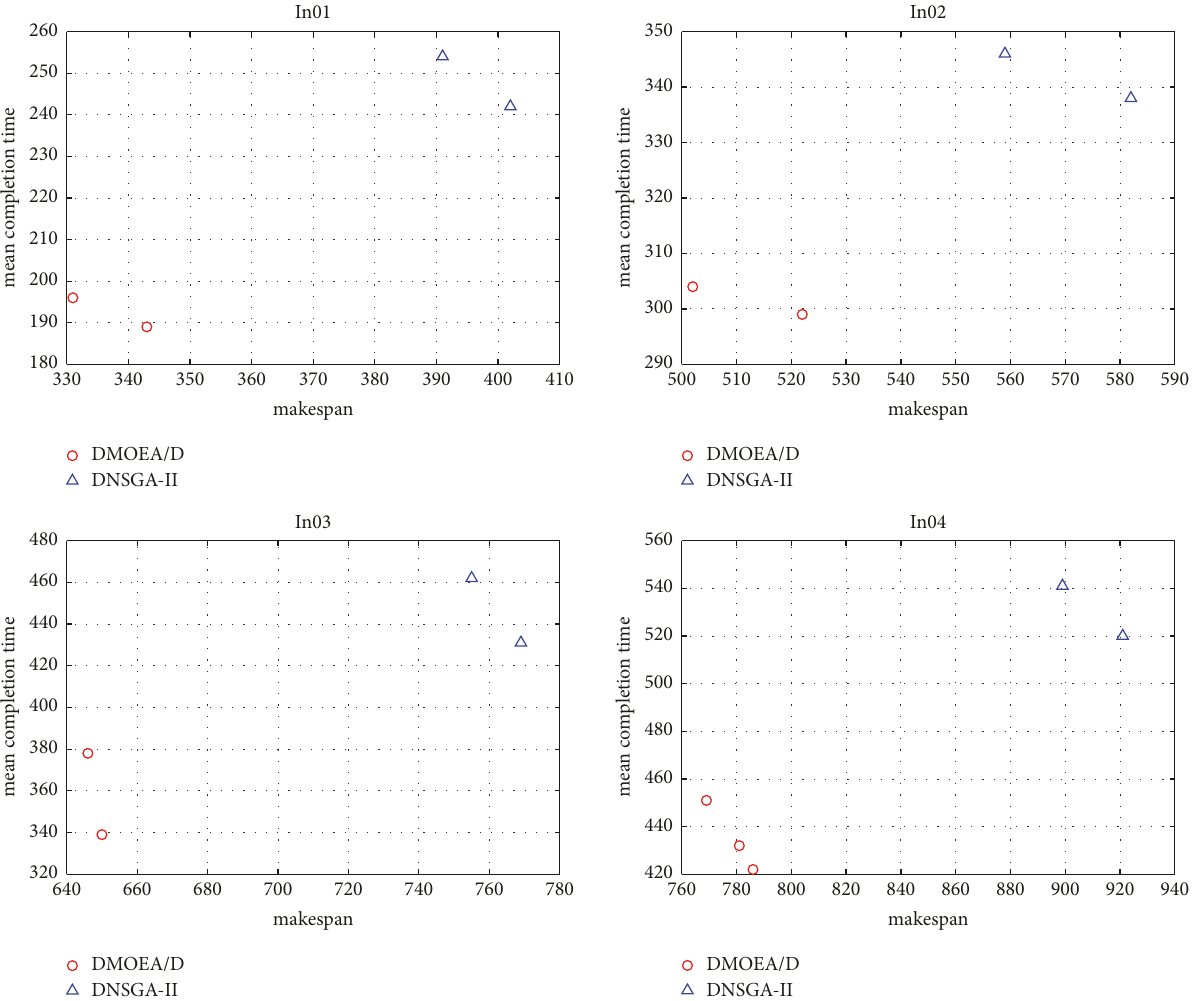
Figure 5: Non-dominated solutions of 2-objective problem on instances